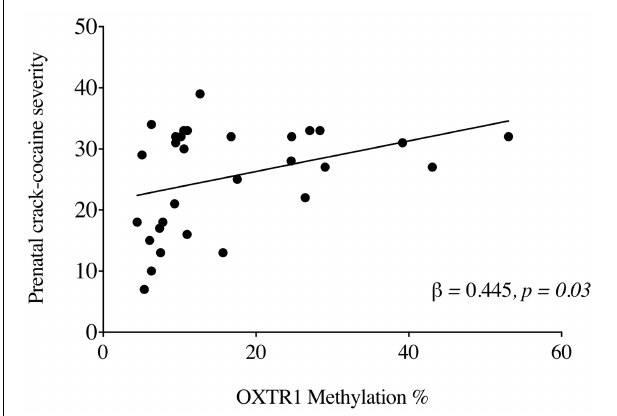
FIGURE 2 | Relationship between levels (%) of OXTR1 methylation in PCE newborns and ASSIST scores for crack cocaine usage among mothers in the 3 months prior to